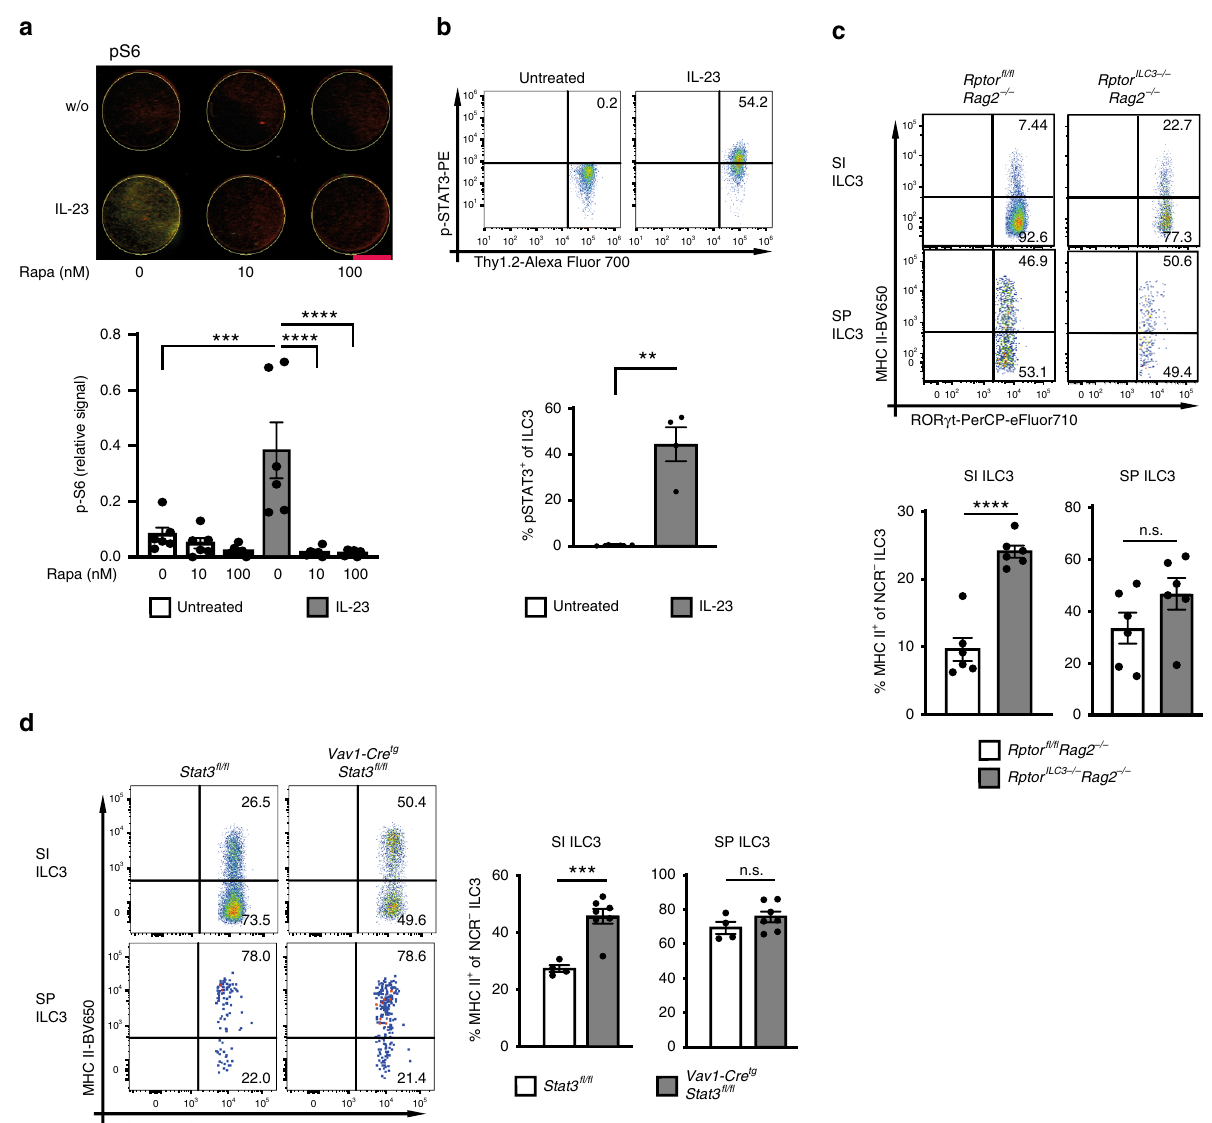
Fig. 6 IL-23 reduces MHC II expression through activation of mTORC1 and STAT3. a Phosphorylation of S6 of SI ILC3s (sorted from Flt3L tg mice) after 48 h stimulation with or without IL-23 and 0, 10, or 100 nM Rapamycin (red = tubulin and green = p-S6). ILC3s were sorted as depicted in Supplementary Fig. 2a. Indicated is the relative phosphorylation of S6 ( fl uorescence signal for p-S6 normalized by fl uorescence signal for tubulin). The indicated bar represents 3 mm. n = 6 distinct samples of fi ve independent experiments. b Phosphorylation of STAT3(Tyr705) of sort-puri fi ed SI ILC3s (Supplementary Fig. 2a) from Rag2 − / − mice after 20 min stimulation with or without IL-23. n = 4 distinct samples of four independent experiments. c MHC II expression of SI and SP ILC3s from Rptor fl / fl Rag2 − / − and Rptor ILC3 − / − Rag2 − / − mice. NCR − ILC3s were gated as shown in Fig. 1. n = 6 mice of two independent experiments. d MHC II expression of SI and SP ILC3s from Stat3 fl / fl ( n = 4 mice) and Vav1-Cre tg Stat3 fl / fl ( n = 7 mice) mice. NCR − ILC3s were gated as shown in Fig. 1. Two independent experiments. Each symbol represents a sample and the bar graph represents the mean ± s.e.m. n.s. not signi fi cant; ** P ≤ 0.01; *** P ≤ 0.001; **** P ≤ 0.0001, calculated with one-way ANOVA (two-tailed) and Bonferroni ’ s multiple comparisons test ( a ) or two-tailed paired ( b ) or two-tailed unpaired ( c and d ) Student ’ s t test. Source data are provided as a Source Data